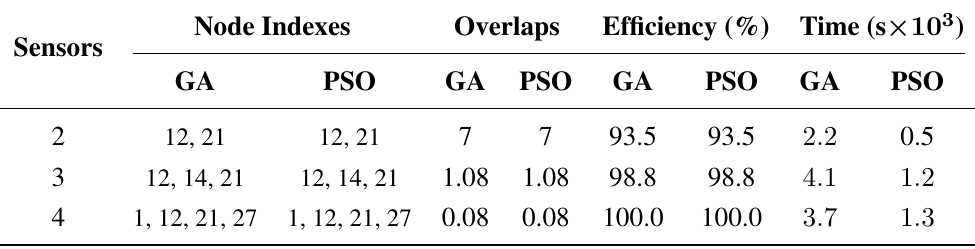
Table 4. Sensor placement in the Hanoi WDN using stochastic approaches and a time horizon